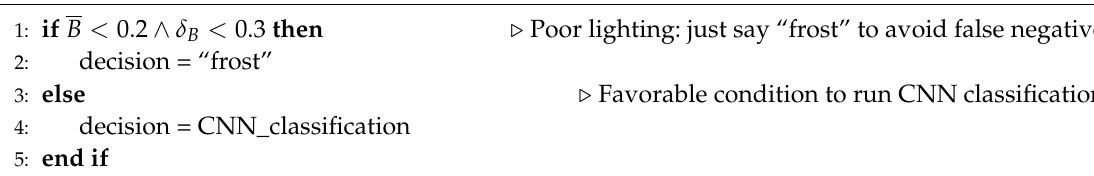
Algorithm 1 Suppressing false negatives through image brightness examination